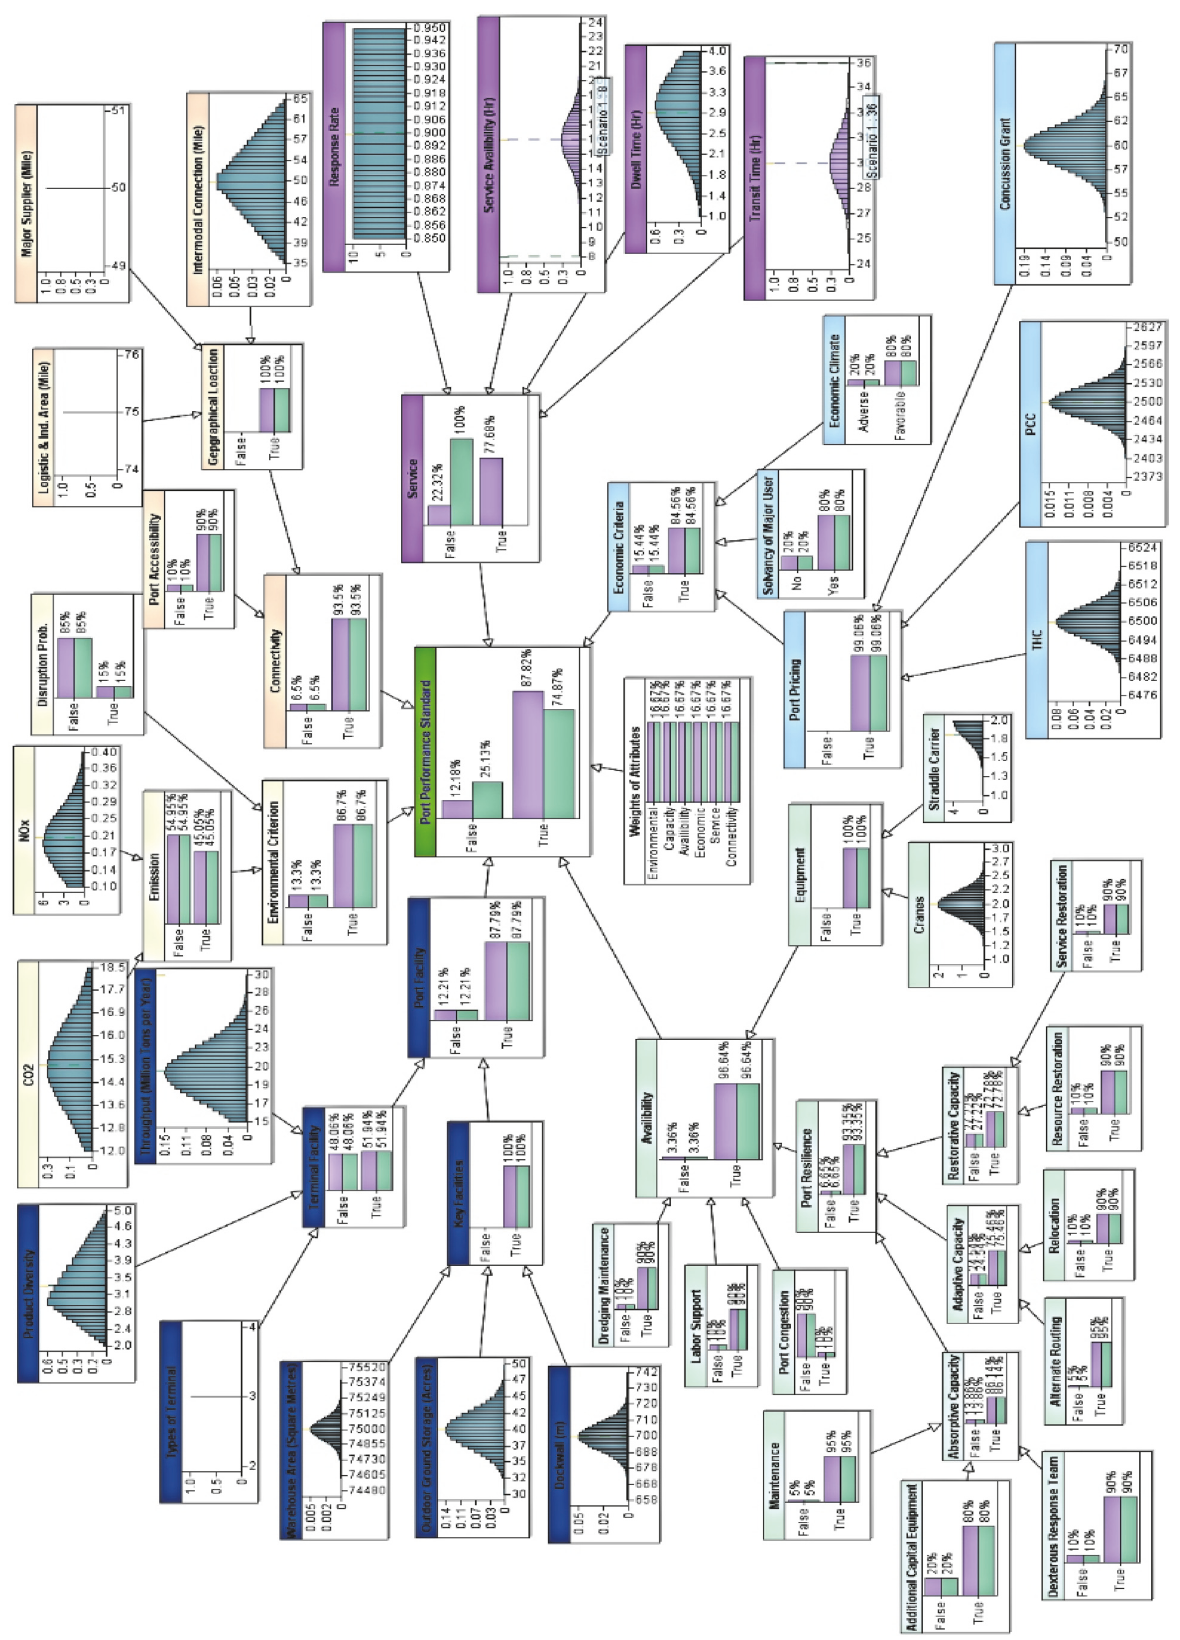
Figure 5: The developed BN model for scenario